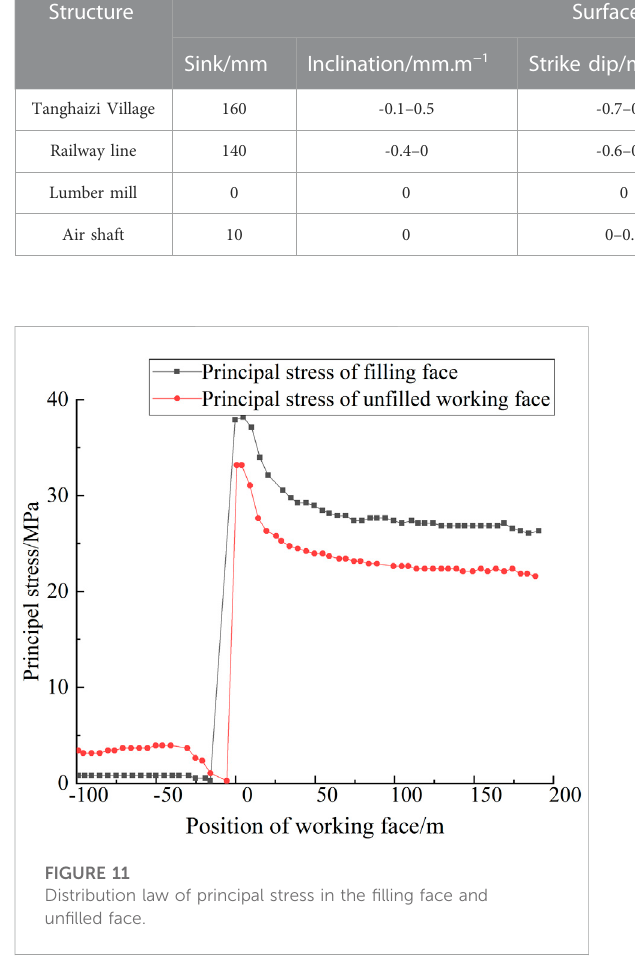
TABLE 1 Surface deformation after fi lling in the working face goaf. Structure